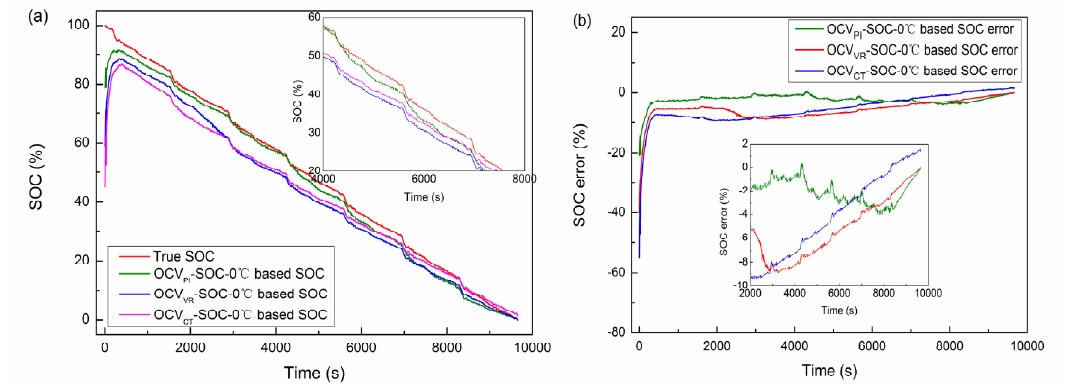
Figure 27. Estimated comparison using the three different OCV–SOC–T relationship maps in the FUDS test at 10 °C: ( a ) SOC and ( b ) SOC error.